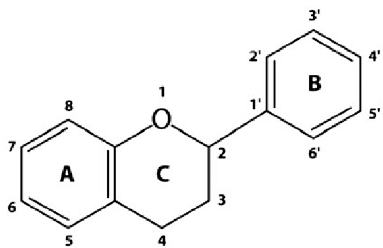
Figure 1. Diphenylpropane skeleton (C 6 C 3 C 6 ) of all flavonoids.